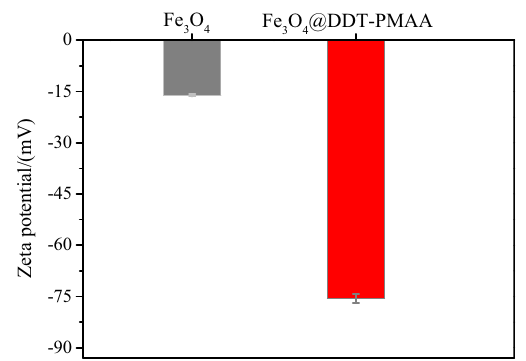
Figure 6: Zeta potential of uncoated and Fe 3 O 4 @DDT - PMAA mag - netic NPs in water ( pH = 7